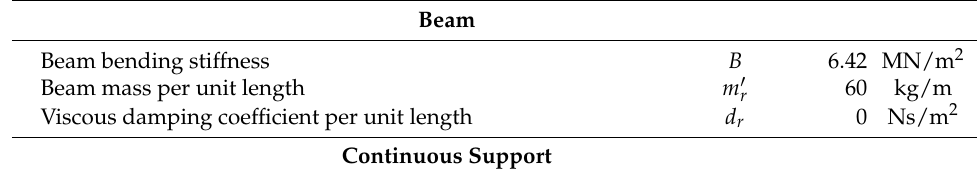
Table 1. Parameters of continuously supported beams.